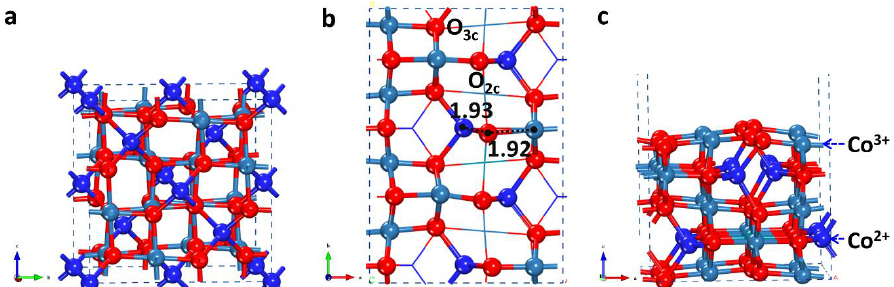
Figure 1. ( a ) Bulk Co 3 O 4 , ( b ) top view and ( c ) side view of Co 3 O 4 (110)-B surface. Co 3+ , Co 2+ , and O atoms are shown in light blue, dark blue, and red, respectively. In addition, in the top view of structures, the atoms at the top and sub layers are illustrated in ball-and-stick model, and the rest are in line model. These illustrations are utilized throughout this paper. The unit of bond lengths are Å. The location of all possible intermediates on the Co 3 O 4 (110) surface should be con- firmed. The most stable adsorption configurations of HCHO and O 2 have been given in